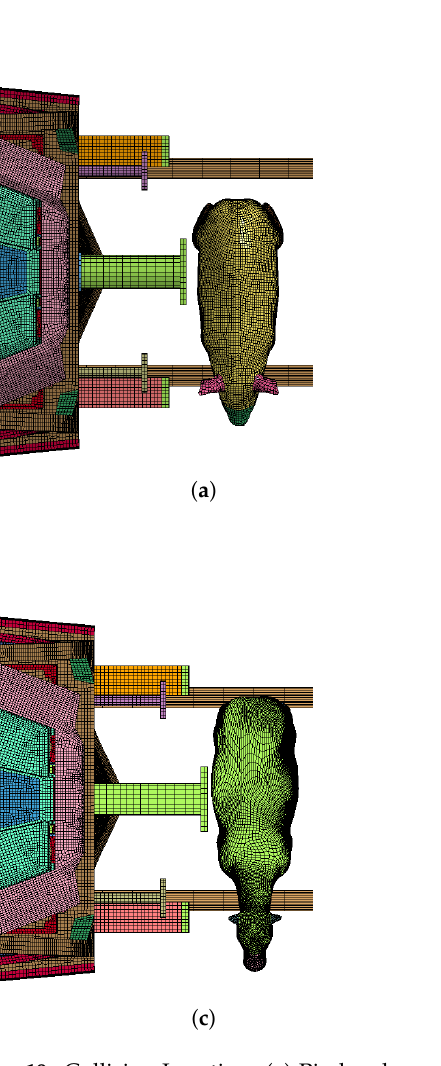
Figure 19. Collision Location: ( a ) Pig head-on collision; ( b ) Pig offset collision; ( c ) Cow head-on collision; ( d ) Cow offset collision.